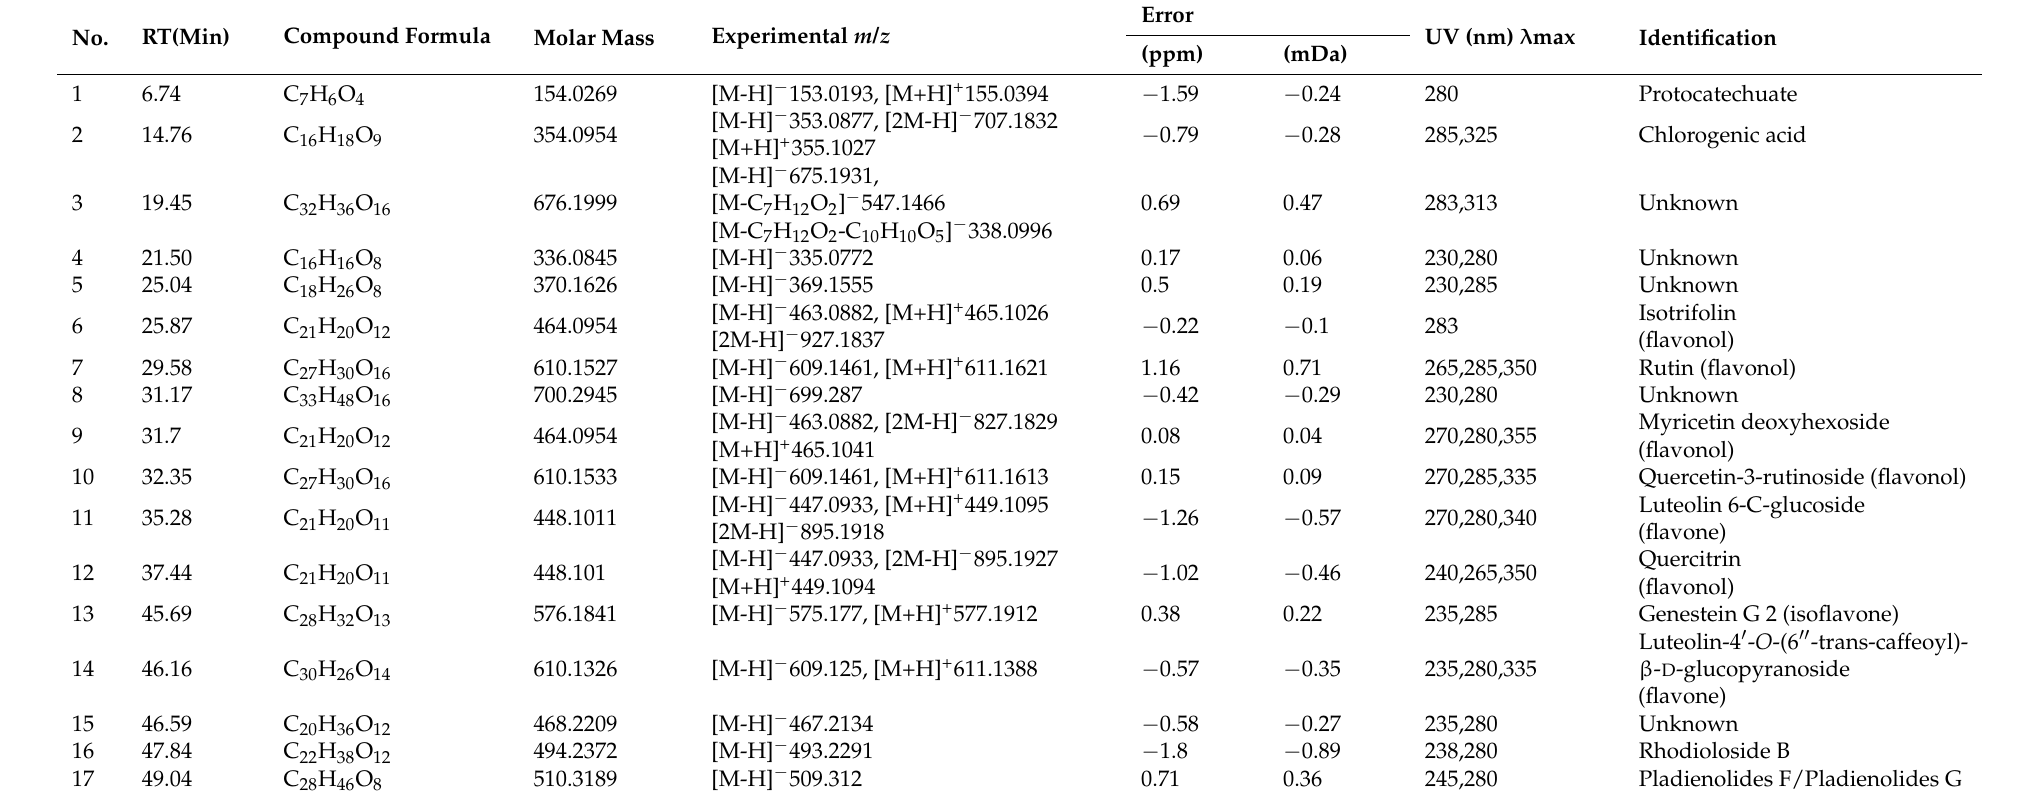
Table 1. Qualitative Analysis of Compounds of Woodwardia japonica with